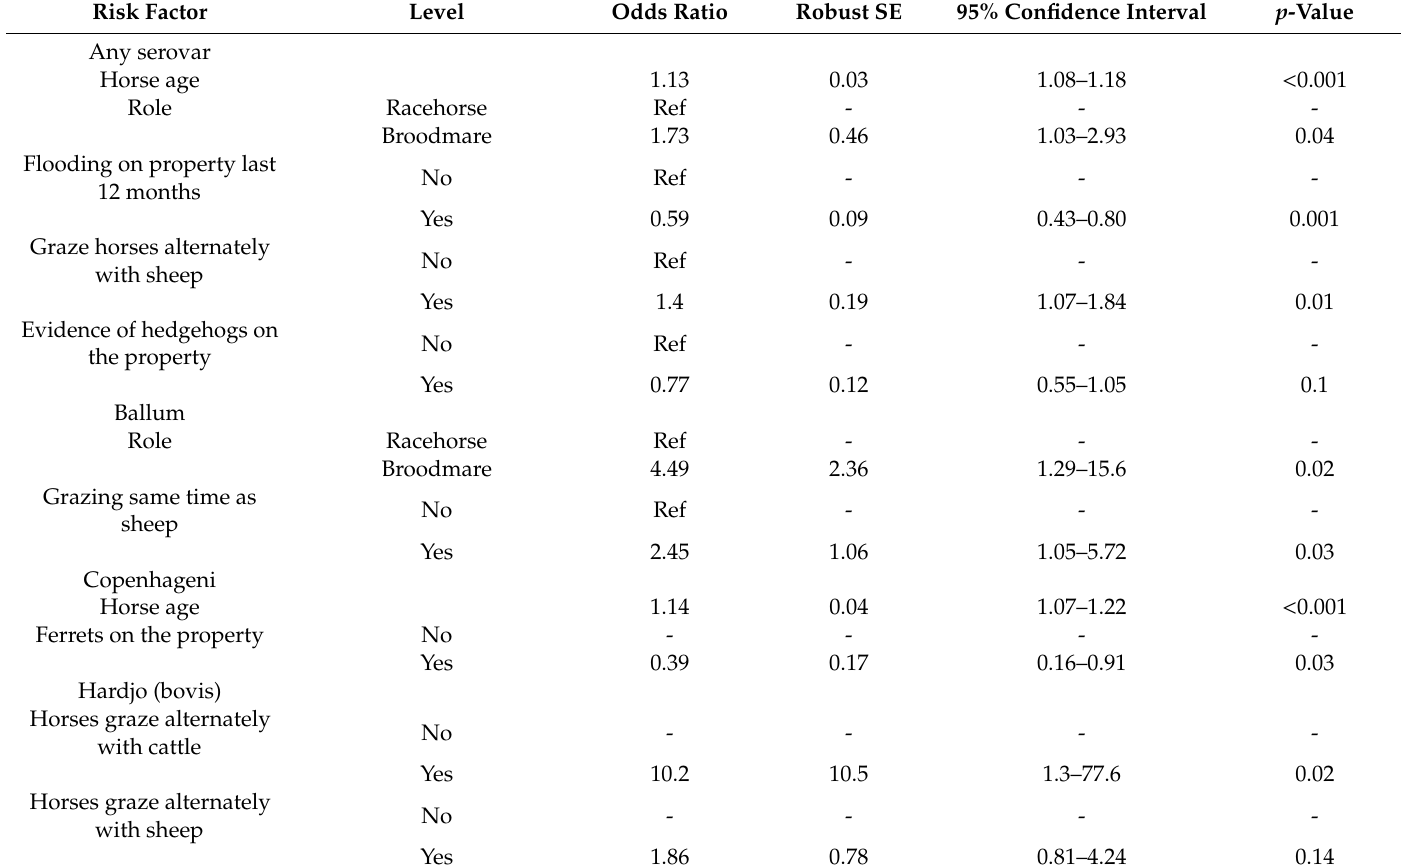
Table 3. Results of the final multivariable logistic regression models investigating horse and property-level risk factors for positive microscopic agglutination tests to any of the Leptospira serovars and to serovars Ballum, Copenhageni, and Hardjo